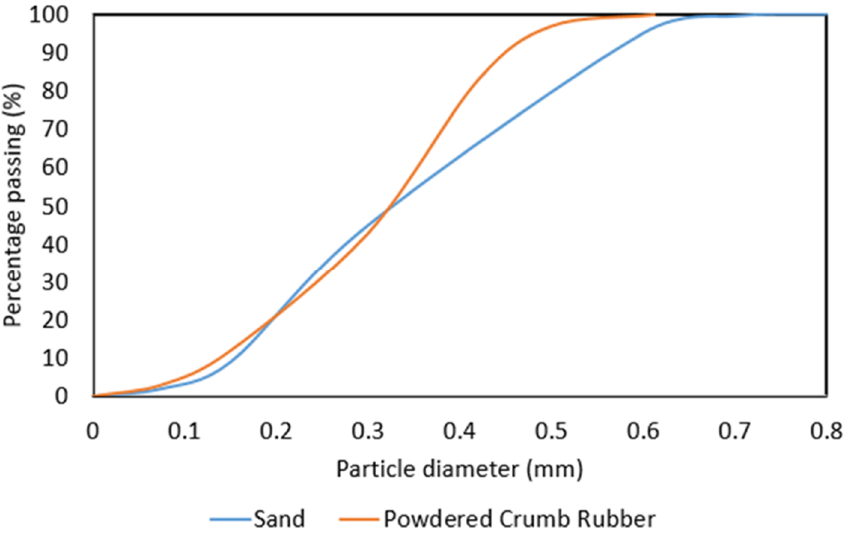
Figure 1. Granulometric curves of sand and powdered crumb rubber.